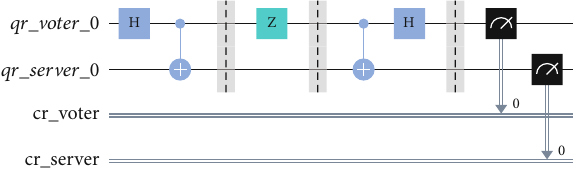
Figure 9: The superdense coding circuit, represented for Alice ’ s vote value of 10 . According to Table 1, the gate used to encode 2 this value in a single qubit is the Z gate.